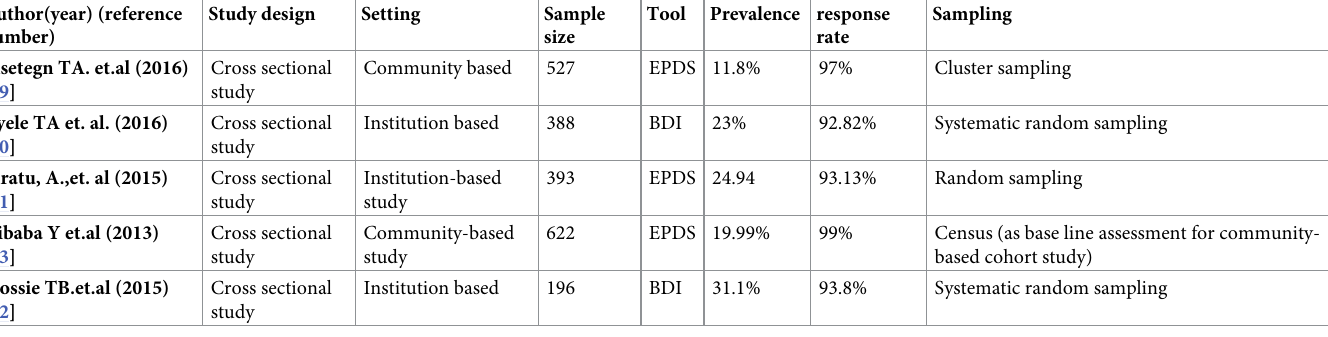
Table 1. Distribution of studies on antenatal depression included in the qualitative analysis based on year, study design, setting, sample size, instrument, and prevalence. Author(year) (reference